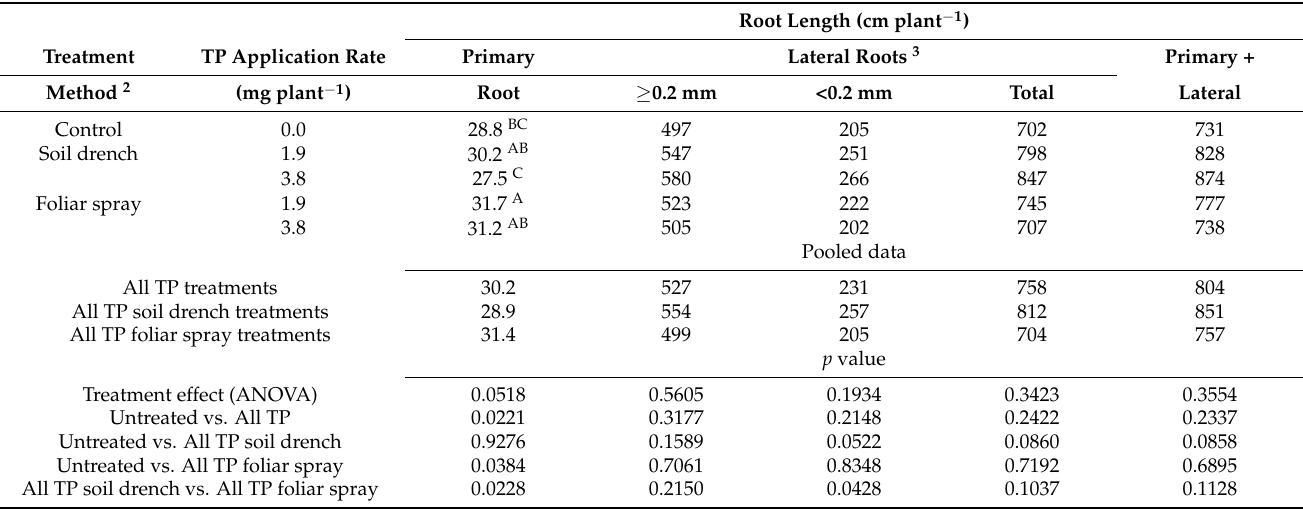
Table 4. Root length of soybean seedlings as affected by tryptophan (TP) soil drench and foliar spray treatments 1